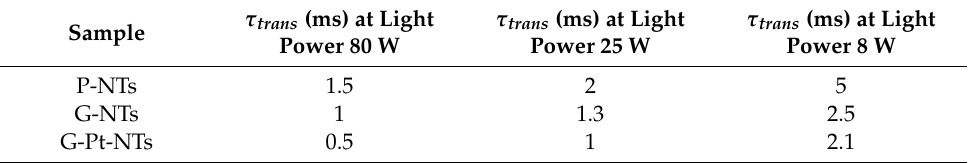
Table 2. The electron transfer time ( τ trans ) of photogenerated electrons determined through IMPS data